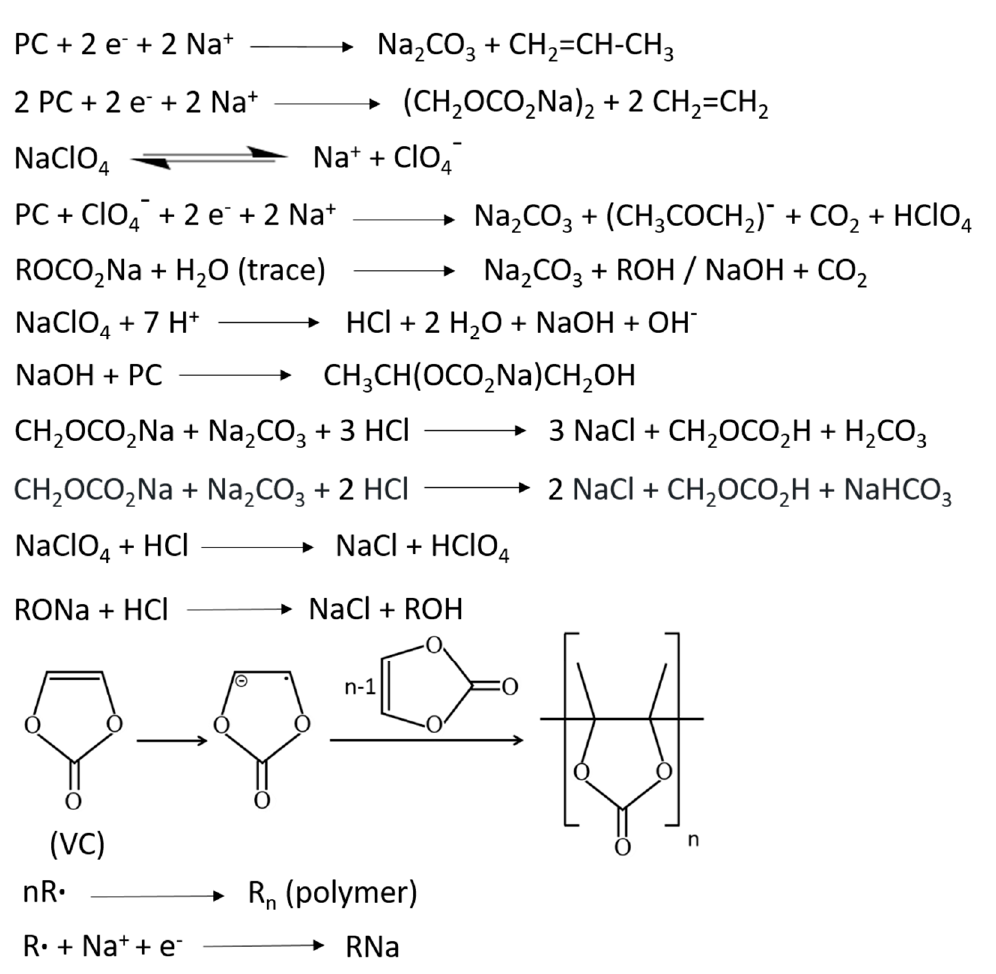
Scheme 1. Reduction reactions of PC-VC/NaClO 4 electrolyte